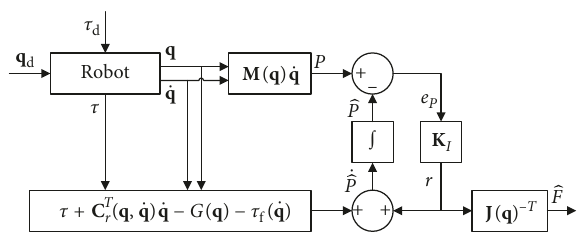
Figure 3: Flow chart of the disturbance